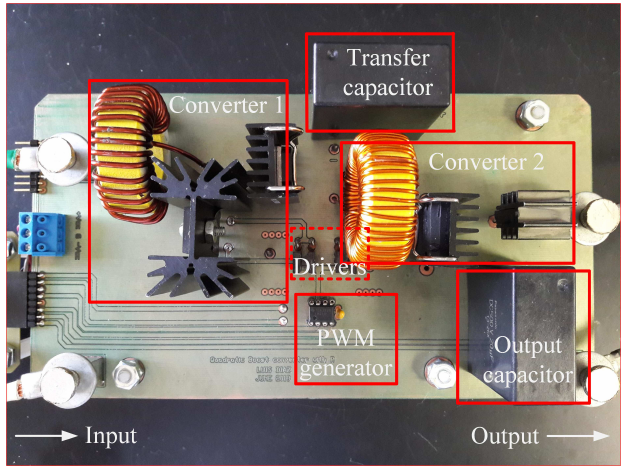
Figure 12. Laboratory prototype of the proposed